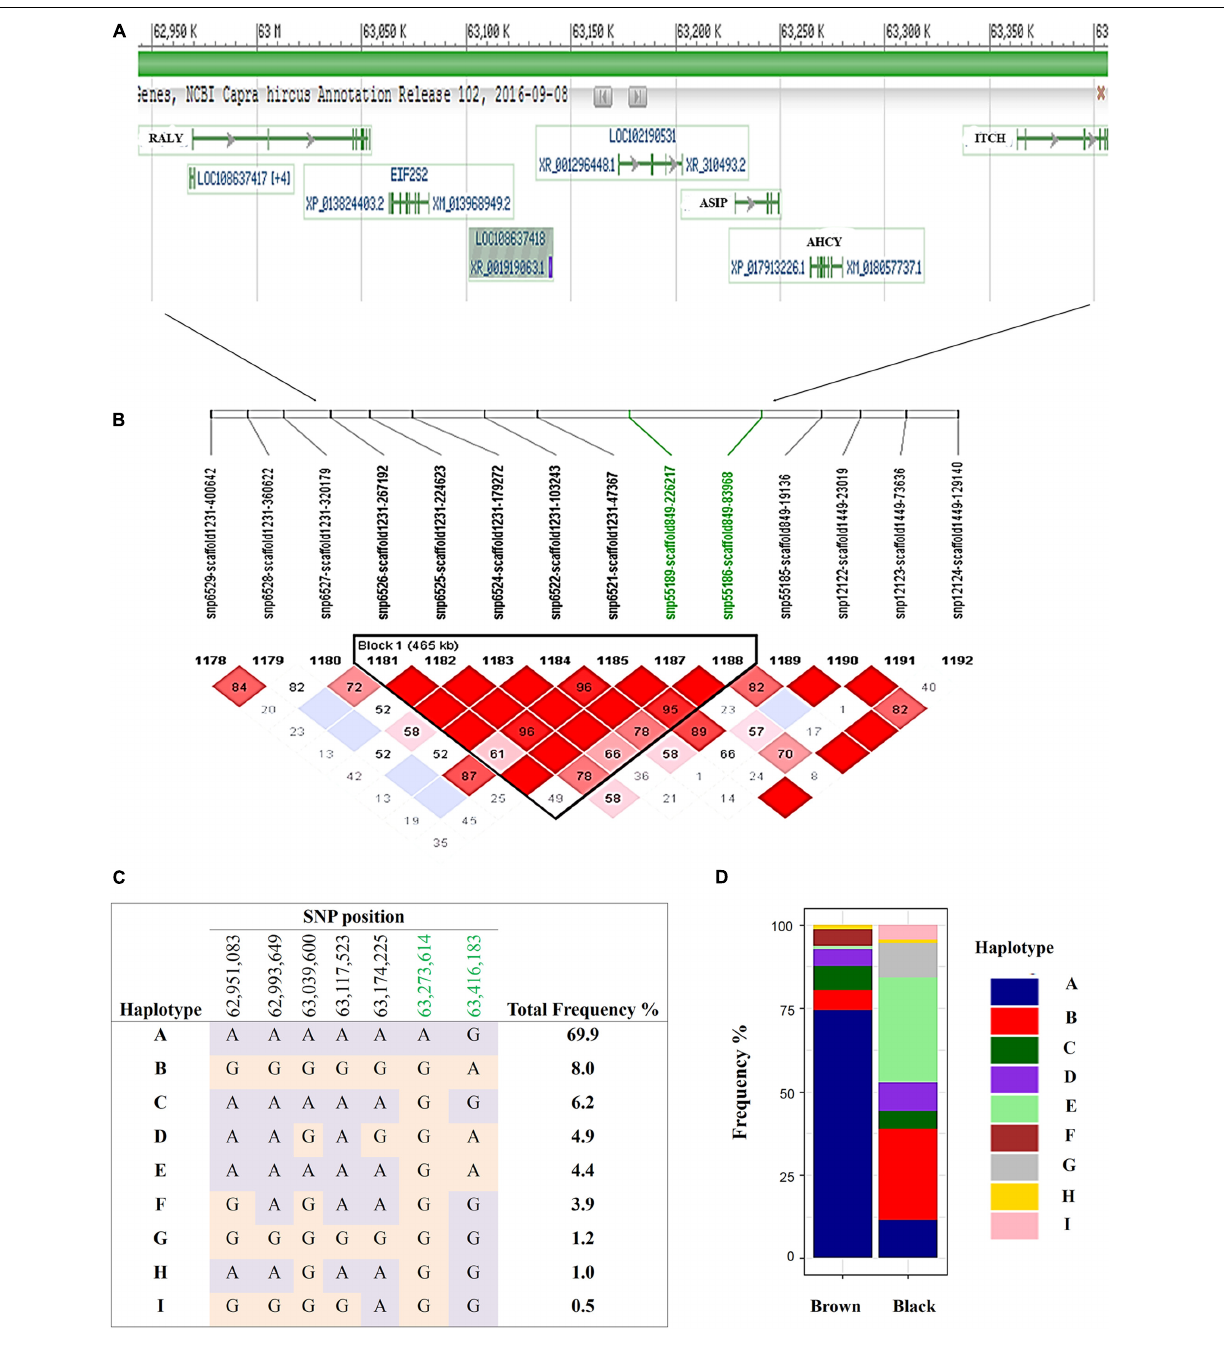
Table S1). Staple length produced a SNP on chromosome 29 with a permutated P -value of 1.58 × 10 − 05 after reaching 886,838 permutations ( Figure 6G ) that fell within the potassium voltage-gated channel subfamily Q member 1 ( KCNQ1 ) gene. The GWAS for efficiency only identified one significantly associated